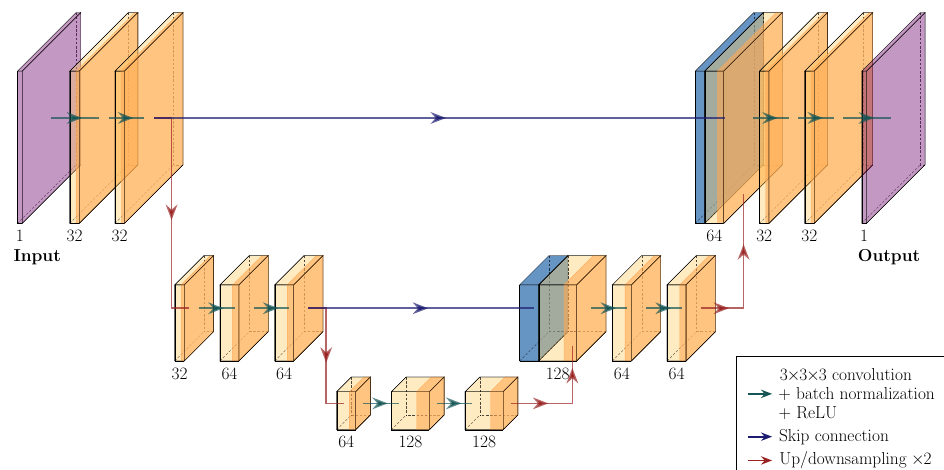
Figure 3. U-Net architecture. Each feature map is represented with 2 out of its 3 spatial dimensions as height and depth, and the channel dimension as width. The number of channels is noted below each feature map. The hidden layers connecting the feature maps are represented by the arrows. The input and output fields are colored in pink, and the feature maps concatenated by the skip connections are colored in blue. The network contains a total of 1.4 million trainable